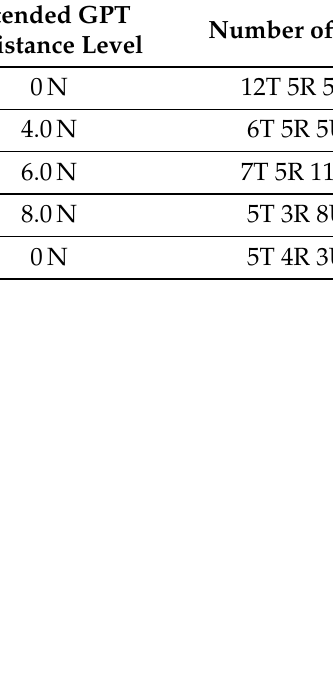
Figure 7. Anterior–posterior ground reaction force from one example